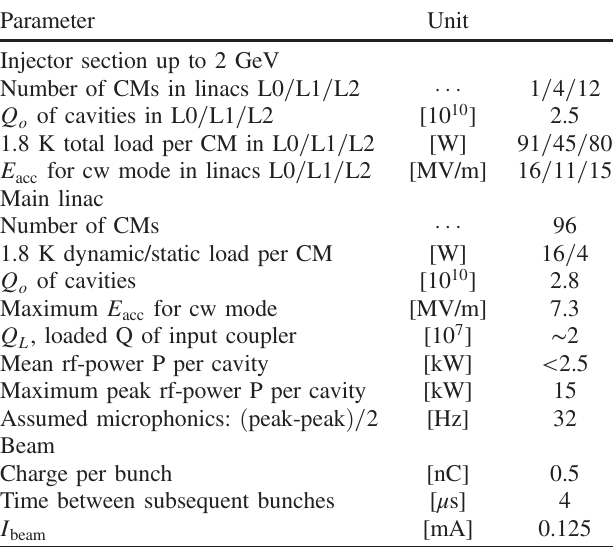
TABLE I. XFEL accelerator parameters for cw/lp modes. Parameter